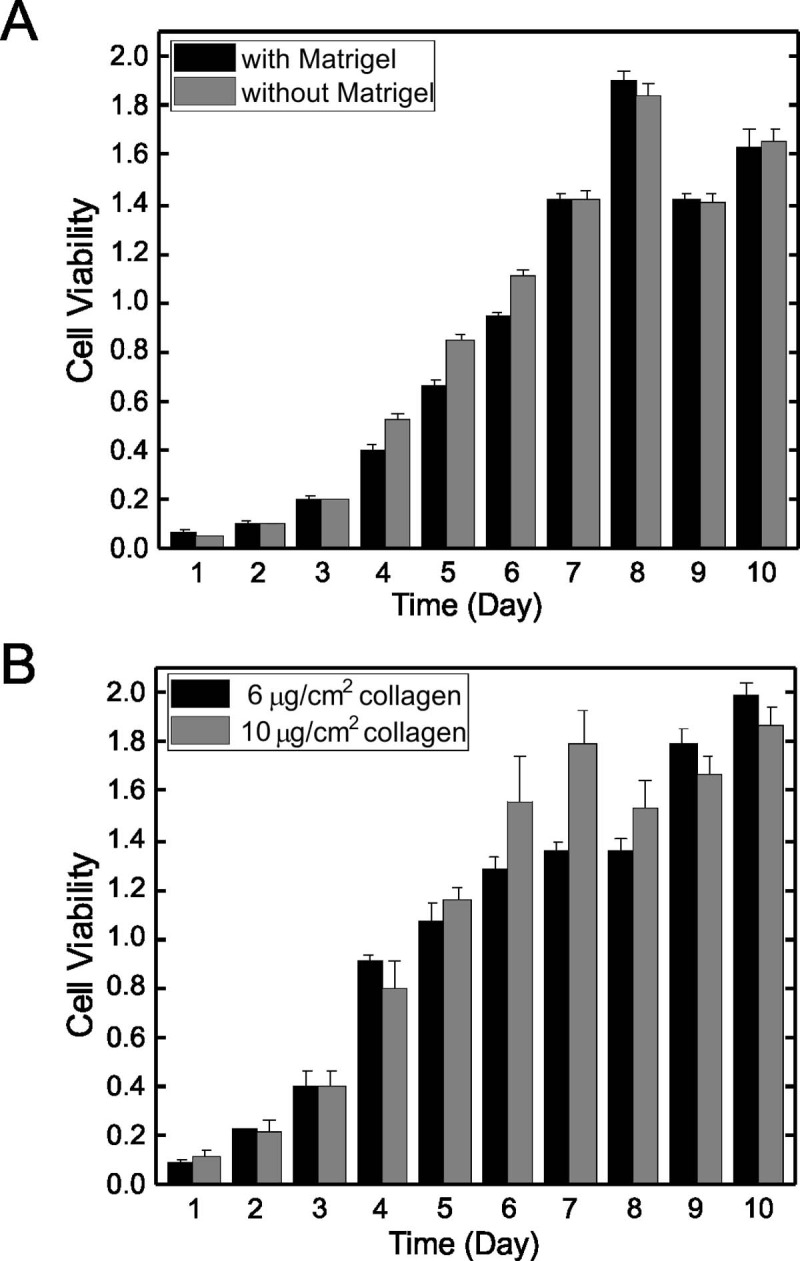
Effect of ECM substrate on growth of EA.hy926 cells.EA.hy926 endothelial cells were seeded at 9000 cells/cm2 on 96 well plates pre-coated with Matrigel (5 μL Matrigel mixed in 95 μL DMEM) or without Matrigel (Panel A) or Collagen Type I dissolved in acetic acid at concentrations of 6 and 10 μg/cm2 (Panel B) and grown for up to 10 days without changing the media. Cell number was determined with the CCK-8 assay. A microplate reader was used to read absorbance of the media at 450 nm. Data are plotted as means ± SEM (n = 3).